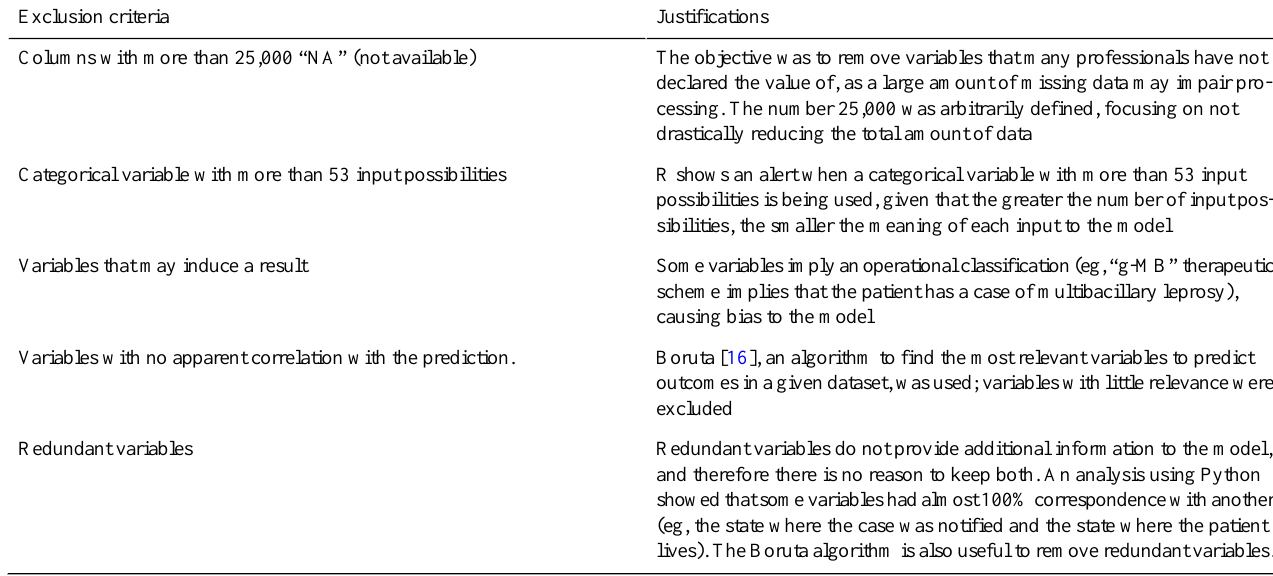
Table 1. Exclusion criteria and justifications.